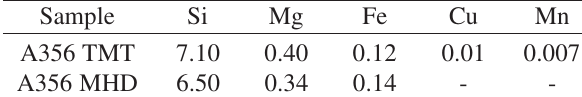
Table 1. Chemical composition of the A356 ingot wt. (%).